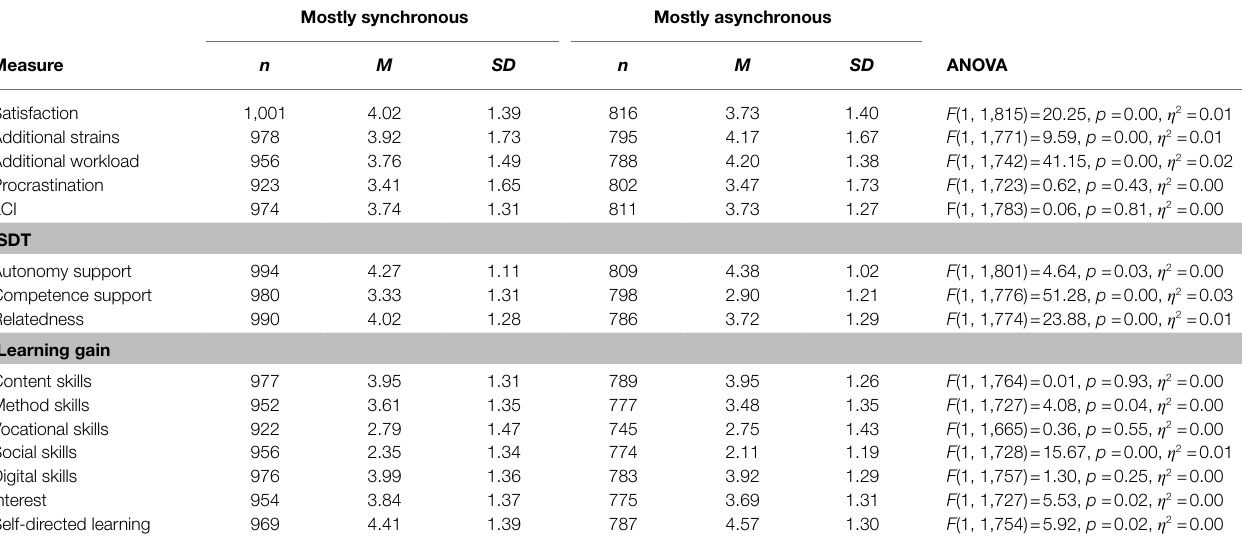
TABLE 6 | Descriptive results for groups and group comparisons of student